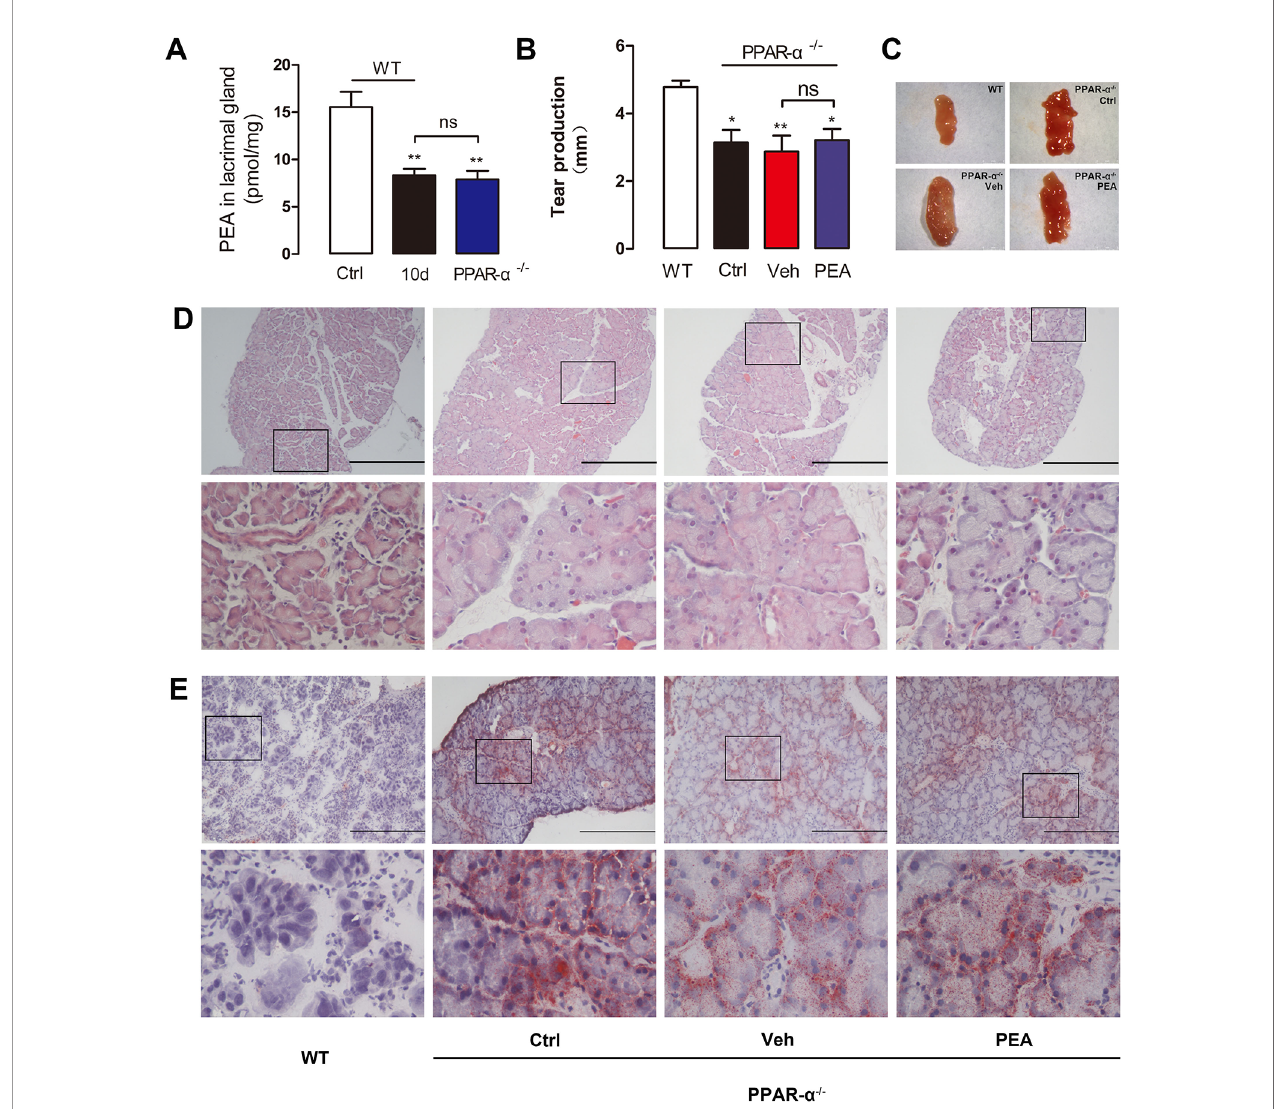
FIGURE 9 | Effects of PEA on PPAR- a − / − mice. The PEA levels in LGs of PPAR- a − / − mice decreased markedly comparing with WT mice (A) . PEA could not increase the tear production (B) , reduce the LG (C) and acinar cell size (D) , and ameliorate lipid deposition (E) in PPAR- a − / − mice. *, P < 0.05, **, P < 0.01 vs. control group, one-way ANOVA followed by Dunette ’ s post hoc , n =